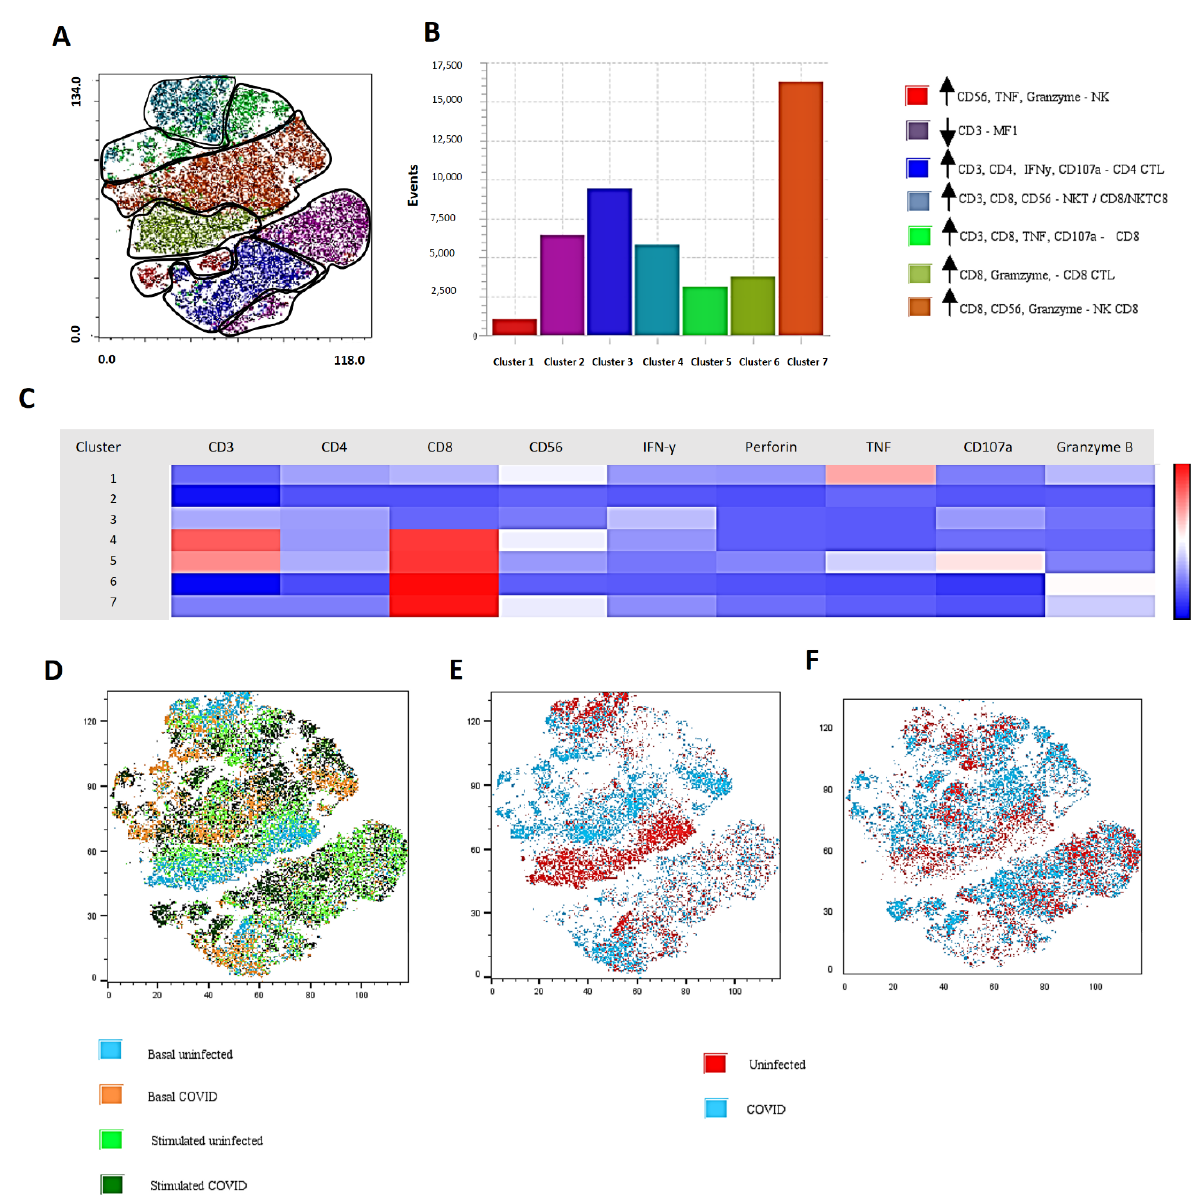
Figure 5. A t-SNE-guided population definition of lymphocyte subtypes from uninfected individuals affected by severe/critical SARS-CoV-2: ( A ) Merged PBMC samples creating a single t-SNE map with the signal strength of lymphocyte phenotypic markers and cytotoxic factors. ( B ) Column graphic representation of the seven clusters identified in the analysis and the corresponding value of events for each of them. ( C ) Heatmap of the MFI of the markers used, identified in each of the clusters. ( D ) Overlay of baseline cell populations from (1) uninfected individuals, (2) basal severe/critical COVID-19, (3) stimulated uninfected, and (4) stimulated severe/critical COVID-19. ( E ) Overlapping cell populations from (1 red) uninfected or (2 blue) infected patients at baseline. ( F ) Overlapping cell populations from (3 red) uninfected or (4 blue) or infected patients in a stimulated situation.